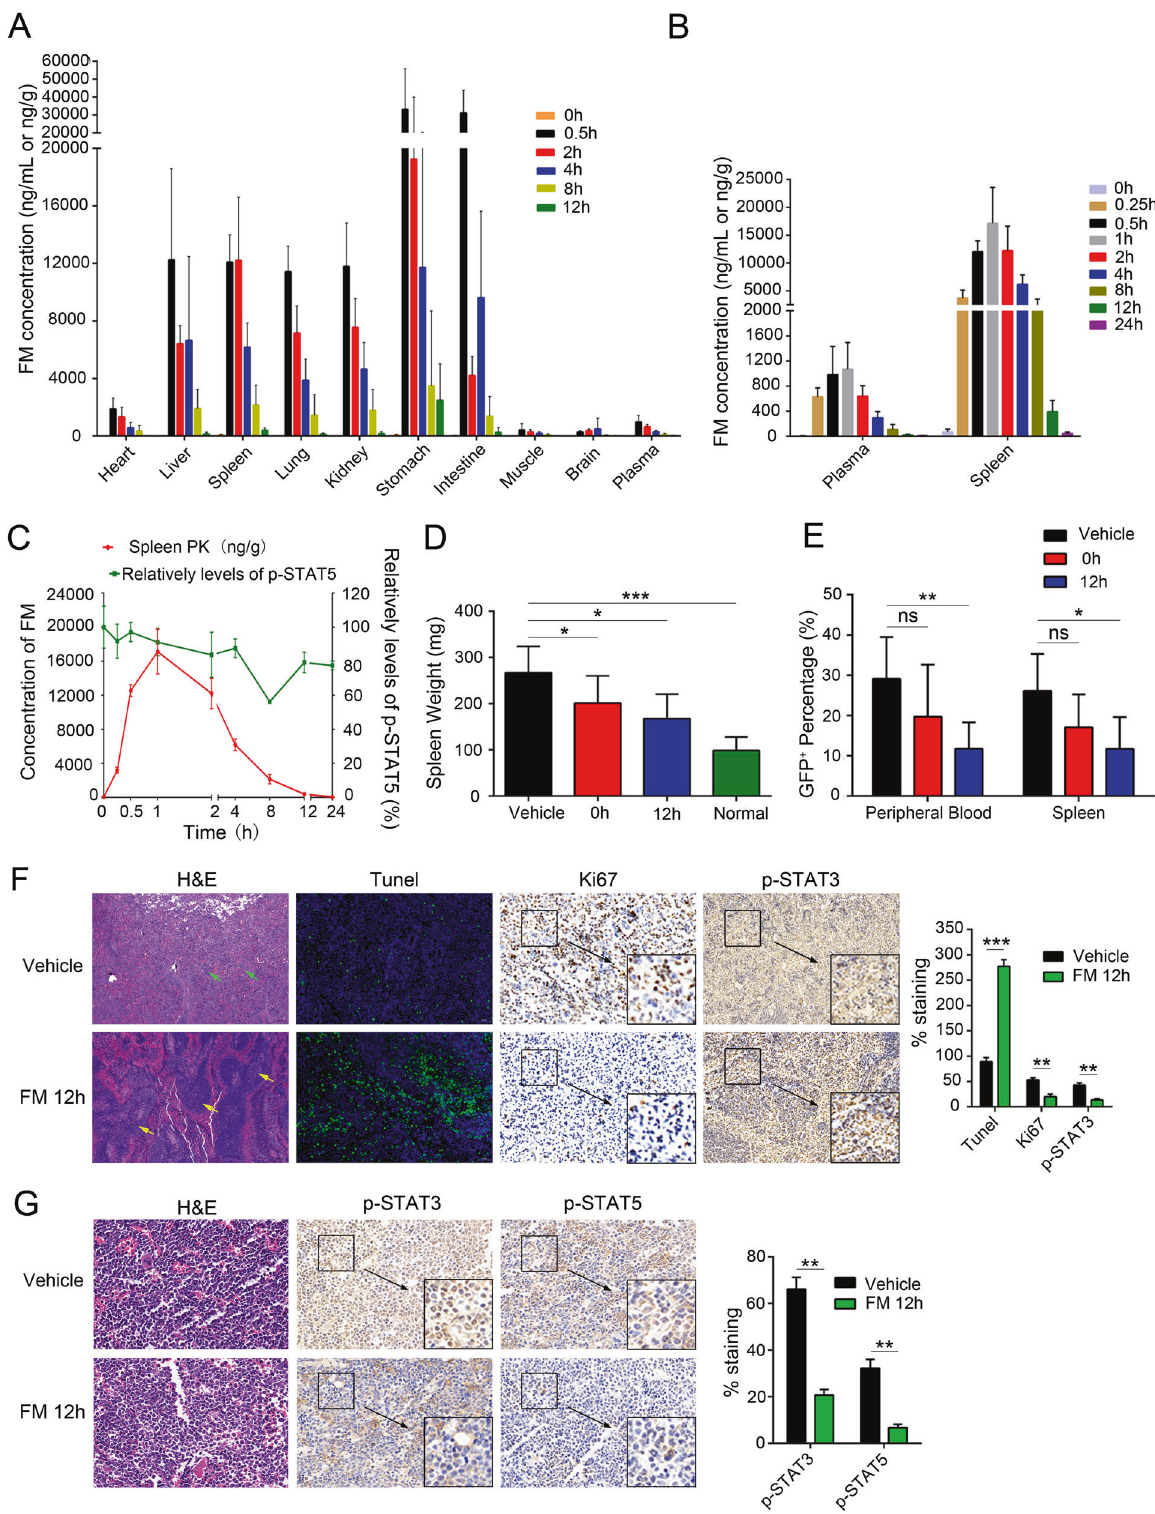
proportion of B220 + cells (B cells) increased, reaching the level of normal mice (Figs. 6E and S5D). JAK2 V617F BMT mice induced an increase in WBCs and HCT, but after FM treatment, the number of WBCs and HCT decreased (Figs. 6F and S5B).